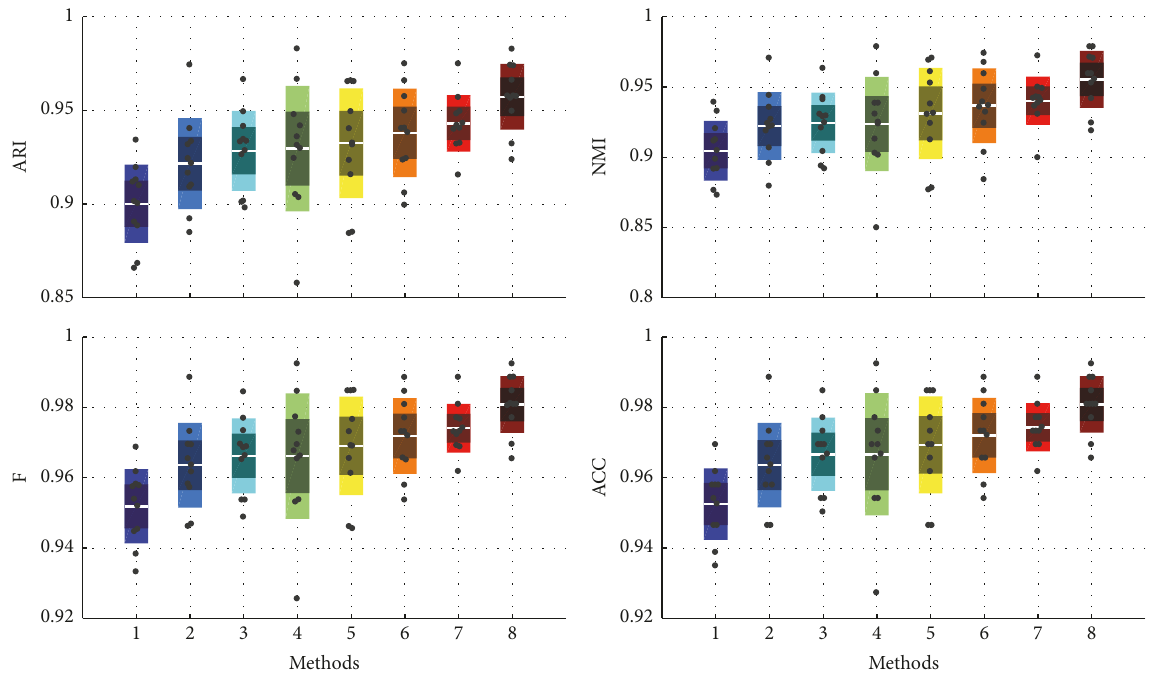
Figure 11: Boxplots of evaluation values for different methods; the x-axis tick labels correspond to 1: VMD-FE-HGWOSCA-SVM, 2: VMD-PE-HGWOSCA-SVM, 3: EMD-MAR-GWO-SVM, 4: EMD-MAR-MHGWOSCA-SVM, 5: VMD-MAR-GWO-SVM, 6 VMD-MAR- HGWOSCA-SVM, 7: VMD-MAR-SCA-SVM, and 8: VMD-MAR-MHGWOSCA-SVM.